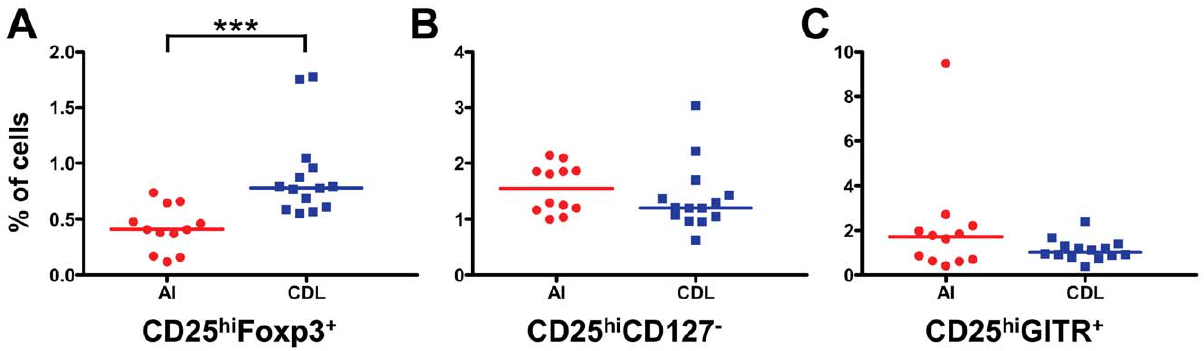
Figure 1. CDL patients have a higher frequency of CD4 + CD25 hi FoxP3 + cells in peripheral blood than AI. PBMCs from AI (n=12) and CDL patients (n=14) were stained for CD4, CD25 and either Foxp3, CD127, or GITR and analyzed by flow cytometry. A . Frequency of CD4 + CD25 hi Foxp3 + cells. B . Frequency of CD4 + CD25 hi CD127 2 cells. C . Frequency of CD4 + CD25 hi GITR + cells. ***p , 0.001, Mann-Whitney test. The median is represented by a horizontal